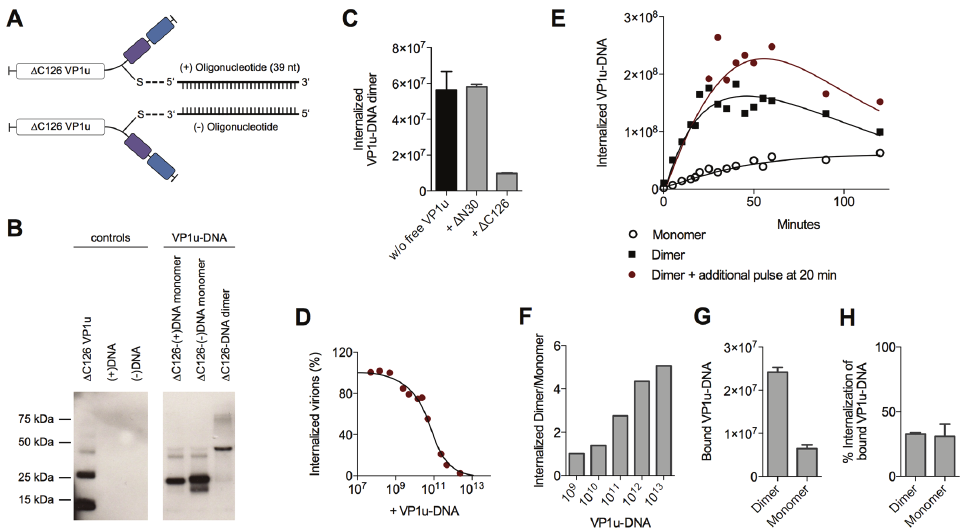
Figure 5. VP1u-DNA as a model for dimerization-enhanced VP1u uptake. ( A ) Schematic depiction of